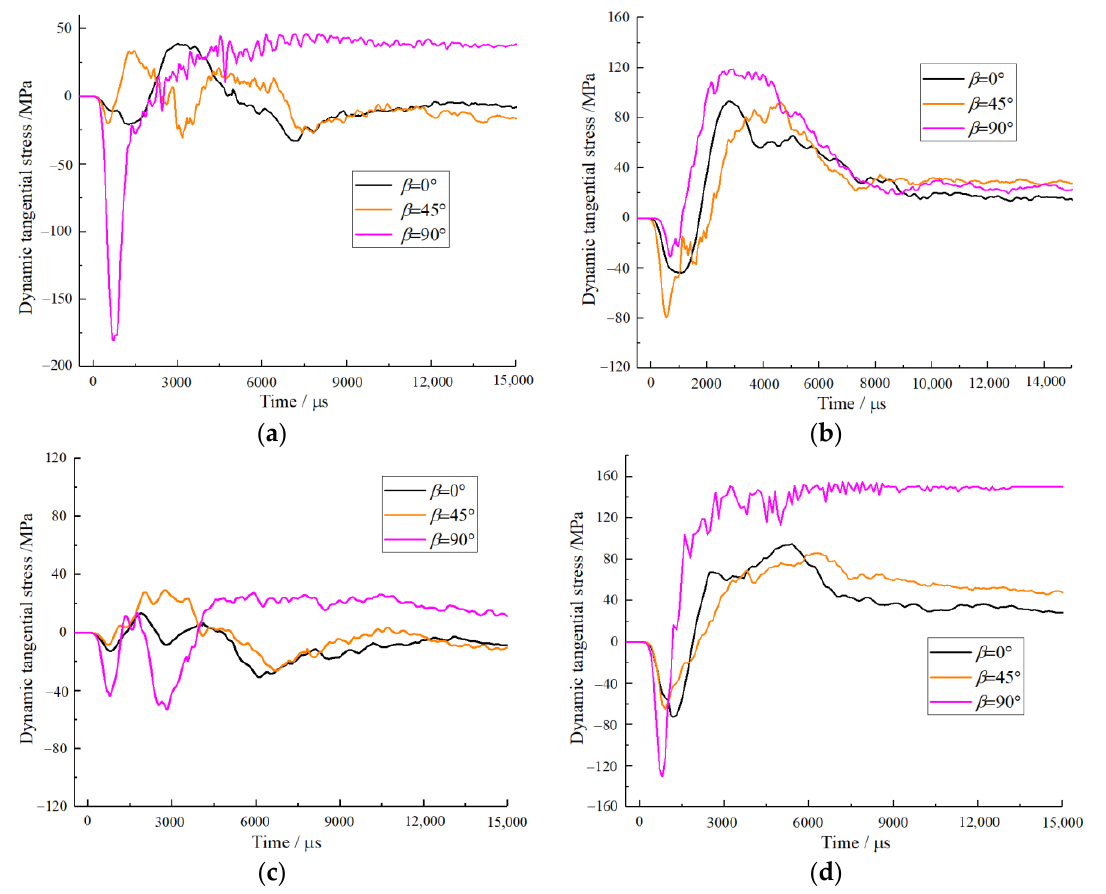
Figure 7. Tangential stress waves around non-adjacent tunnel under different tunnel dips: ( a ) B1; ( b ) B2; ( c ) B3; ( d ) B4.